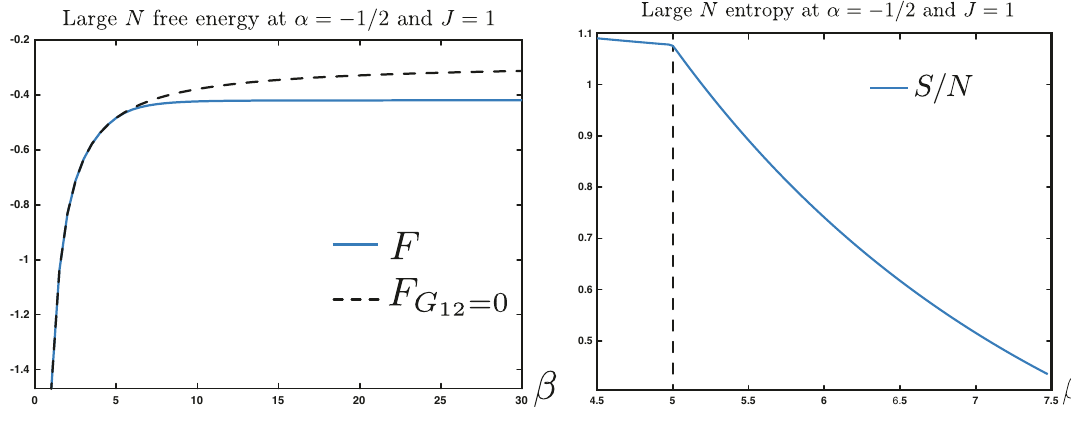
Figure 5 . Numerical calculation of the large N free energy and entropy at α = − 1 to [1], for fixed α we observe a second-order phase transition from the U(1) symmetric phase to U(1) broken phase. We numerically observe that S/N approaches zero, rather than a finite number, as β → ∞ . This may be explained by the U(1) sigma model, where one expects S 0 ∼ log N instead of powers in N